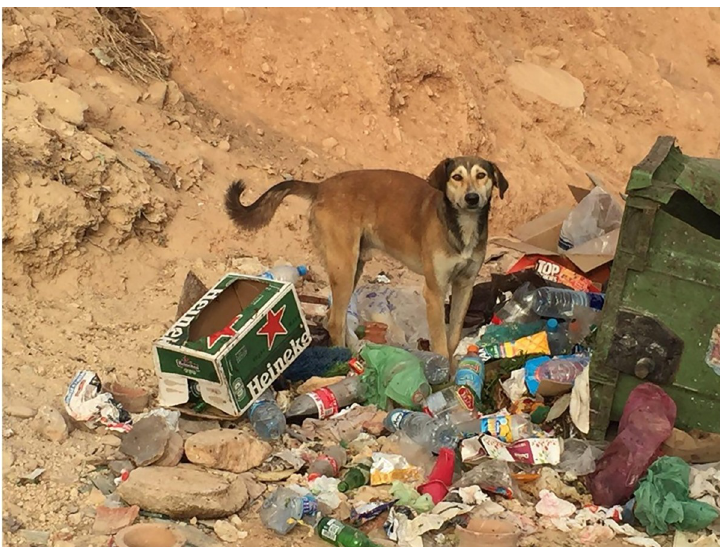
Fig 1. Free ranging dog looking for food in the garbage. In the study area the experience of finding food in the garbage, surrounded by human’s artefacts (such as plastic bottles, boxes, bags, etc..) is common since early age.